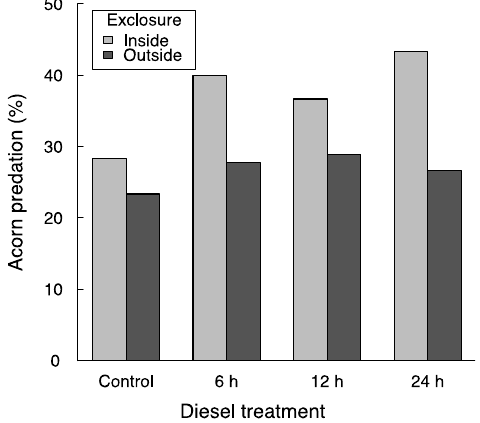
Figure 1. Average acorn removal in the field experiment after 9 days. Exclosures prevented the access of ungulate acorn predators. The diesel treatment included four levels of submersion time of acorns in diesel. The differences in average removal rates between exclosure and diesel treatments were not significant (see Results).